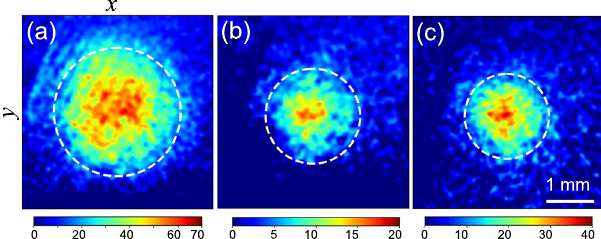
Fig. 7 Images of the output probe beam pro fi le taken at Δ c = − 1 Γ . Here, the phase shift induced by the dipole – dipole interaction is minimal. a The image was taken in the absence of the atoms and at Ω p = 0.1 Γ . b , c The images were taken in the presence of the atoms, and Ω p = 0.1 Γ and 0.2 Γ , respectively. Color represents the gray level detected by the electron- multiplying charge-coupled device camera. We fi t each image with a Gaussian function and draw a white-dashed-line circle of the diameter equal to the e − 1 full width of the best fi t. The diameters of the circles in ( a ), ( b ), and ( c ) are 2.6, 2.0, and 1.8 mm,